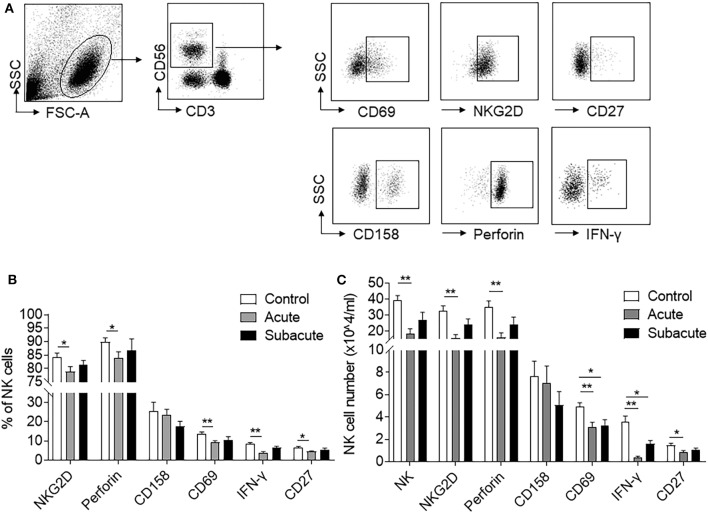
Reduced NK cell number and activity after ischemic stroke. Peripheral blood was obtained from healthy controls and patients with ischemic stroke during acute (<3 days) and subacute (days 7–10) stages. (A) Flow cytometry plots show the expression of activation markers (CD69), cytotoxicity receptors (NKG2D and CD158), maturation marker (CD27), and functional proteins (Perforin and IFN-γ) in peripheral NK cells. (B) Bar graph shows the cell percent of NK cells that express CD69+, NKG2D+, CD27+, Perforin+, or IFN-γ+ in healthy control and patients with ischemic stroke during acute and subacute phases. (C) Bar graph shows cell number of peripheral NK cells and NK cells that express CD69+, NKG2D+, CD27+, CD158+, Perforin+, or IFN-γ+ in healthy control and patients with ischemic stroke during acute and subacute phases. n = 18 for control subjects. n = 20 for stroke patients. *p < 0.05 and **p < 0.01. Data are presented as means ± SEM.